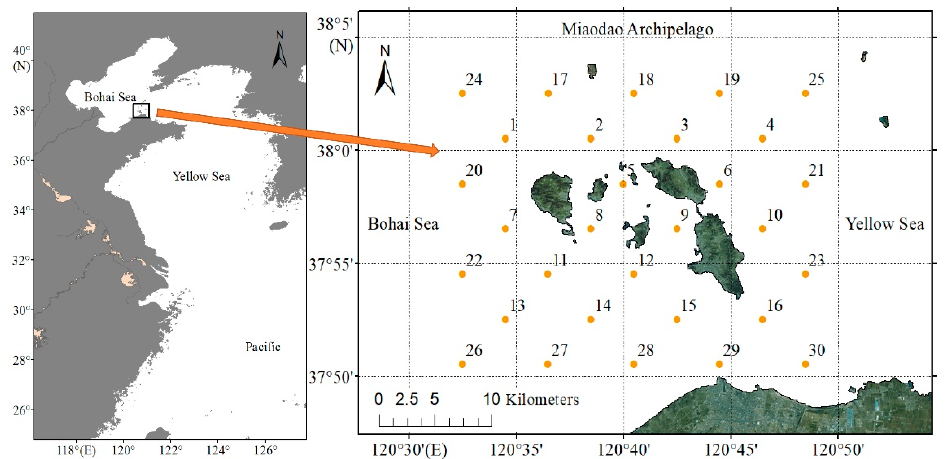
Figure 1. The location and sampling stations of the Miaodao Archipelago.